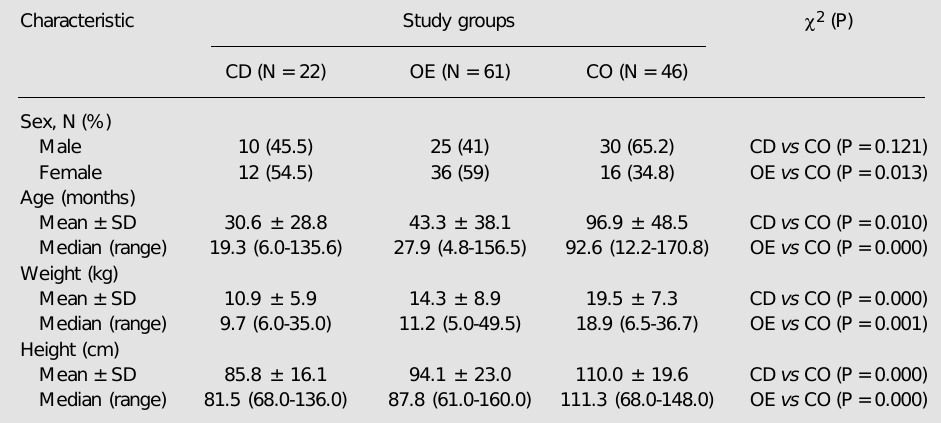
Table 1. Sex, age, weight and height distribution of patients in the groups with celiac disease (CD), other enteropathies (OE) and control (CO).